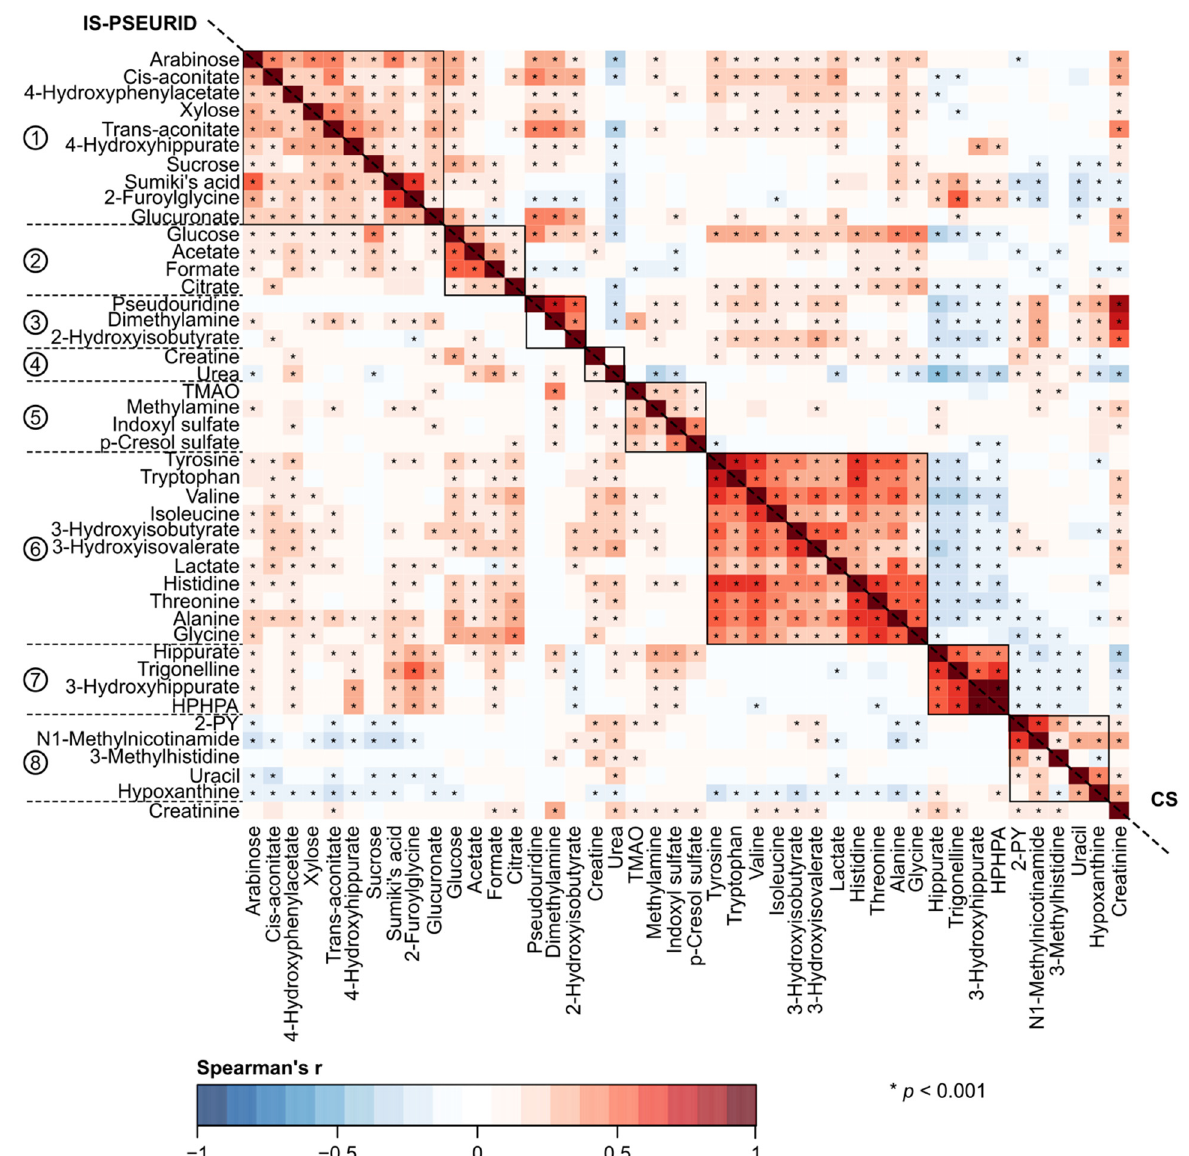
Figure 3. The urinary metabolite–metabolite associations as indicated by Spearman’s rank correlations adjusted for sex. The down-left triangle shows results for the pseudouridine normalization (IS-PSEURID) and the top-right triangle for the constant sum normalization (CS). The order of metabolites (with creatinine added to the last row) is the same as in Figure 1 and based on the two-dimensional hierarchical clustering of the IS-CREA heat map. The reference metabolite correlations are left blank in their corresponding heat maps. Abbreviations: TMAO, trimethylamine N-oxide;